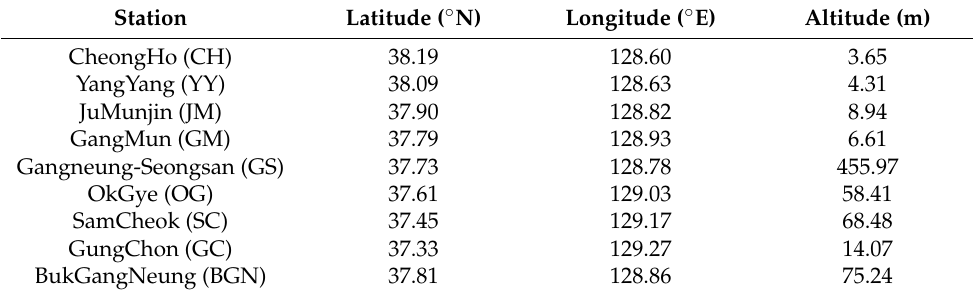
Figure 1. ( a ) Computational domain in WRF having triple nesting with horizontal resolution of 9 km (d01), 3 km (d02), and 1 km (d03) and ( b ) locations of the observational stations in d03. Station GangNeung (GN; in red) is used only for selecting the sea breeze cases. Since the buoy location (37.54 ◦ N, 130.0 ◦ S) is out of the range of domain 3 (d03), the buoy site (in red) is marked with a box. The wind profiler radar is located at BukGangNeung (BGN). See Table 1 for the detailed information on the stations in blue. Table 1. Main attributes of meteorological stations used for optimization and validation. See the station locations on the map in Figure